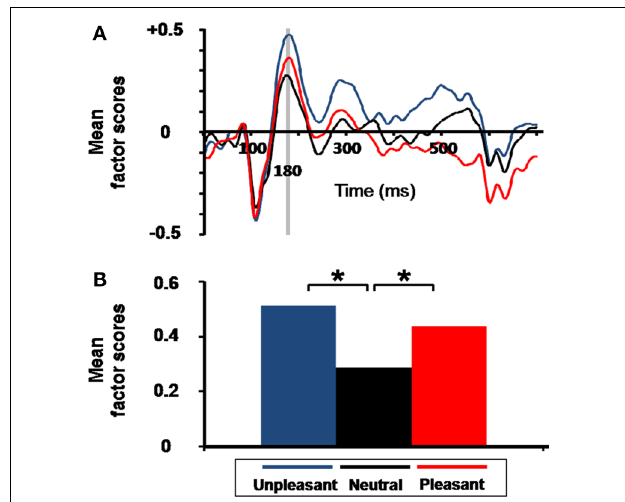
FIGURE 5 | Emotional arousal effect on virtual event-related magnetic fi eld (ERF). (A) Grand average of the mean factor scores of the occipitotemporal component (SF3) as a function of time and emotional condition. Gray bar indicates the latency (revealed by TF3 extracted from temporal PCA), for which a signifi cant emotional arousal effect was observed. (B) Mean factor scores of TF3 (180 ms latency) for SF3 (occipitotemporal component) as a function of emotional content (* p = 0.004). Factor scores (y axis) are unitless dimensions.